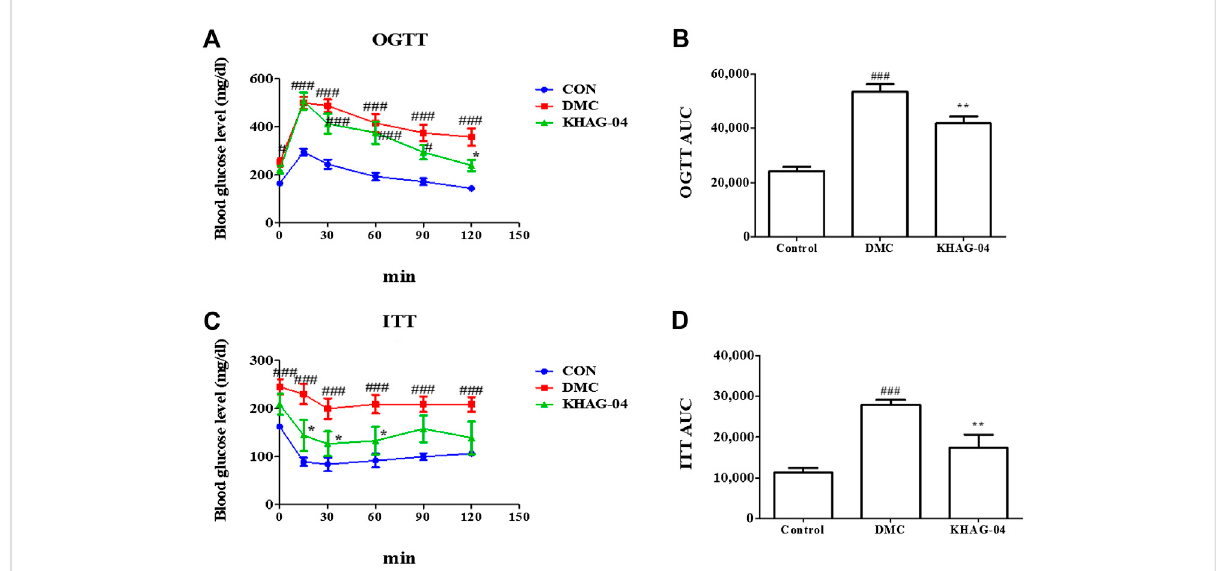
FIGURE 6 EffectsofKHAG-04ontheoralglucosetolerancetest(OGTT)andtheinsulintolerancetest(ITT)inT2DMmice.60%kcalhigh-fatdiet(HFD)and 60 mg/kg streptozotocin (STZ)-stimulated T2DM mice were treated with vehicle and KHAG-04 (10 mg/kg) for 12 weeks. (A) Intraperitoneal insulin tolerance test (ITT), and (B) the area under the curve (AUC) of ITT. (C) Oral glucose tolerance test (OGTT) and (D) the area under the curve (AUC) of OGTT. All data are indicated as mean ± SEM ( # p < 0.05, ### p < 0.001 vs Control; * p < 0.05, ** p < 0.01 vs 60% kcal high-fat diet + 60 mg/kg streptozotocin;